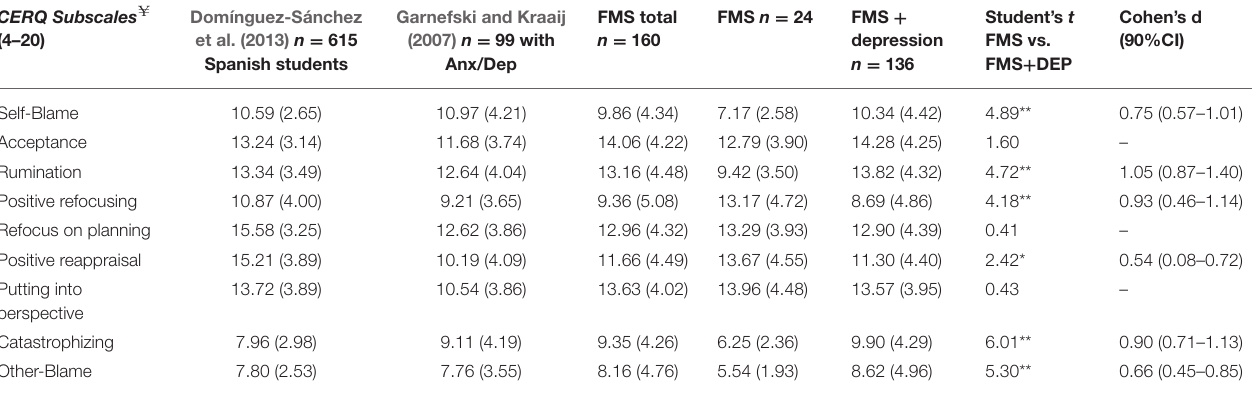
TABLE 5 | Discriminant Validity: Subgroup Comparisons (FMS vs. FMS + Depression) on the CERQ Subscales in Subsample 1 ( n = 160). CERQ Subscales U